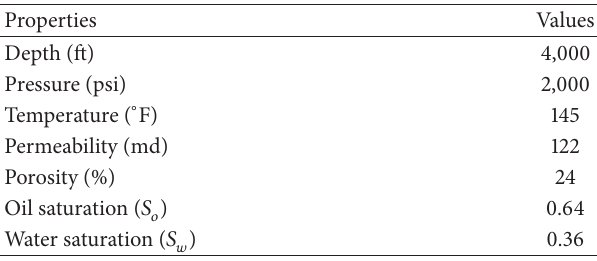
Table 6: Economic parameters for optimal